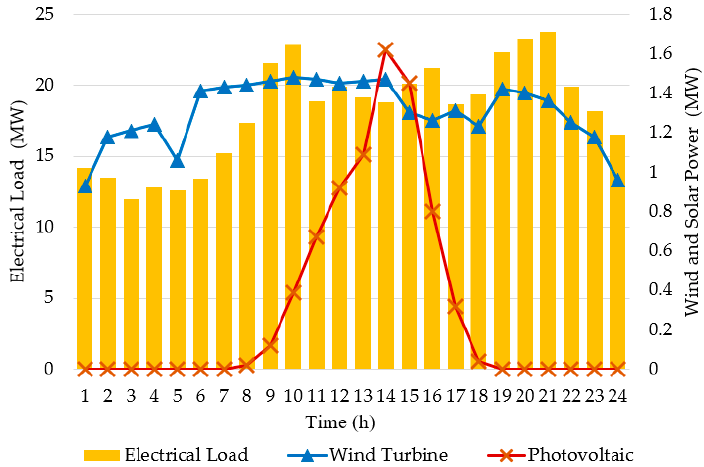
Figure 7. Profiles of wind power, solar power and electrical load in a typical day. Appl. Sci. 2019 , 9 , x FOR PEER REVIEW